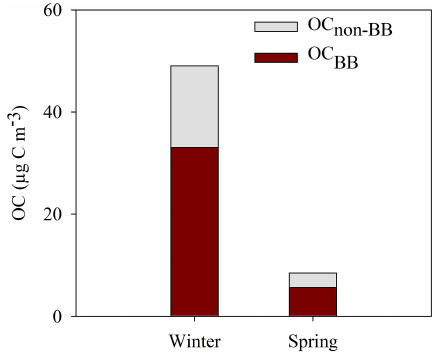
Figure 13. Relative contributions (µgCm − 3 ) of OC BB and OC non-BB to PM 2 . 5 in Ulaanbaatar during winter and spring of